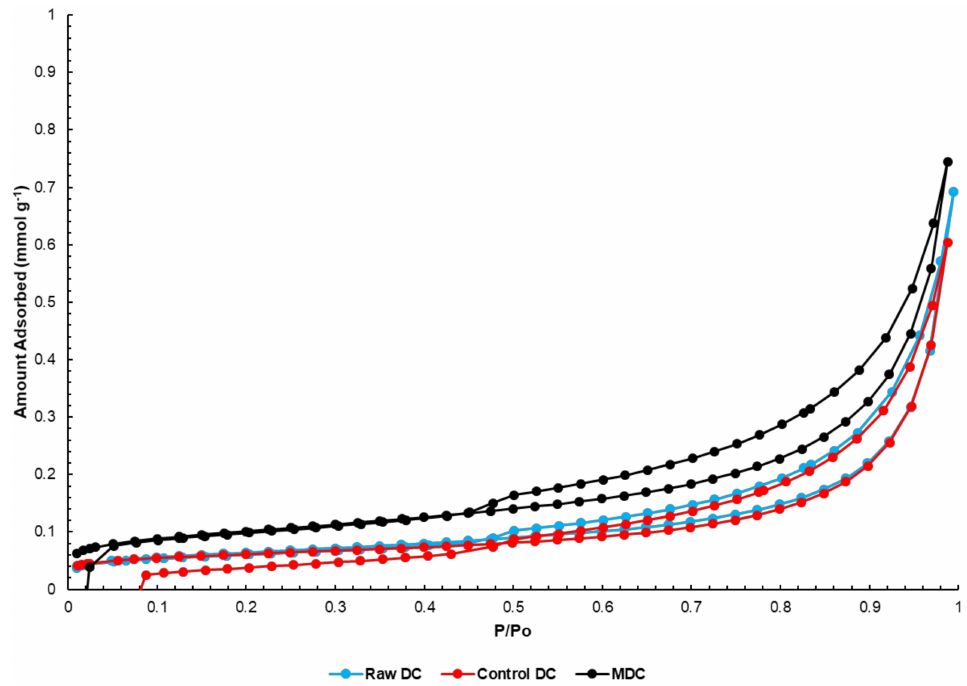
Figure 3. Curves for N2 adsorption-desorption for the various drill cuttings catalysts.